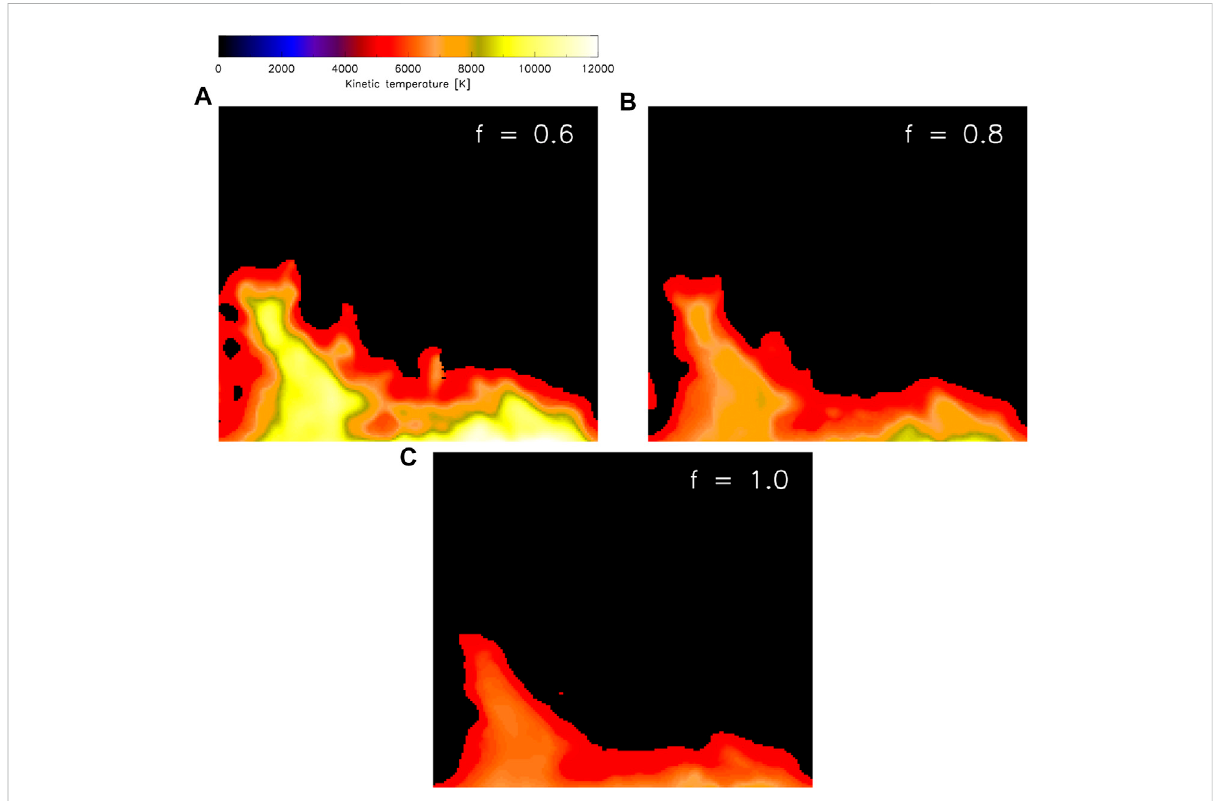
FIGURE 7 Invertedmapsofkinetictemperaturesfordifferentvaluesofthe fi llingfactor: (A) f =0.6, (B) f =0.8, (C) f =1.0.The fi eld-of-viewisthesameasin Figure 5. Reproduced from Heinzel et al.